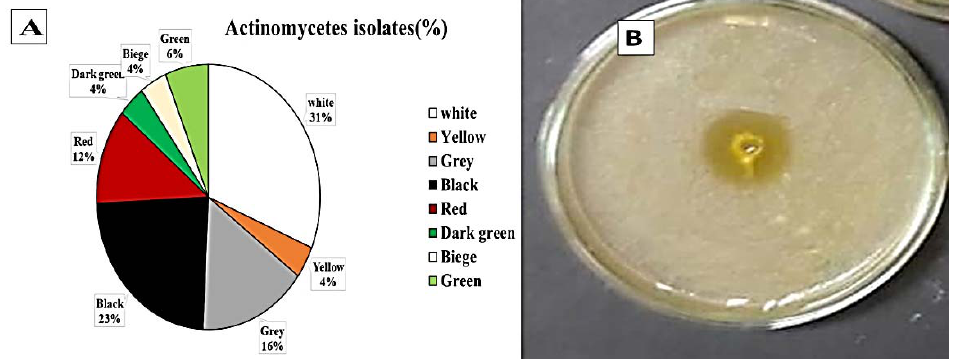
Figure 1. Morphological characteristics of laccase producing actinomycetes in soil samples. ( A ) col ‐ ony color of Actinomycetes isolated from soil near industrial water effluent, Cairo, Egypt. ( B ) the most efficient producing laccase enzymes Streptomyces st 45 isolates on VMM agar plates incubated at 30 °C for 5–7 days indicating orange zone around well filled with 0.1mL of actinomycetal culture.